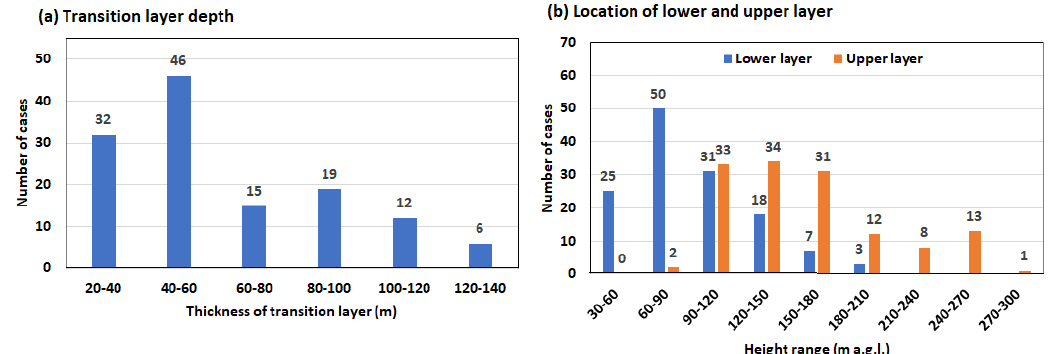
Figure 6. Characteristics of the transition layer in the vertical profiles of PM 10 concentrations in type